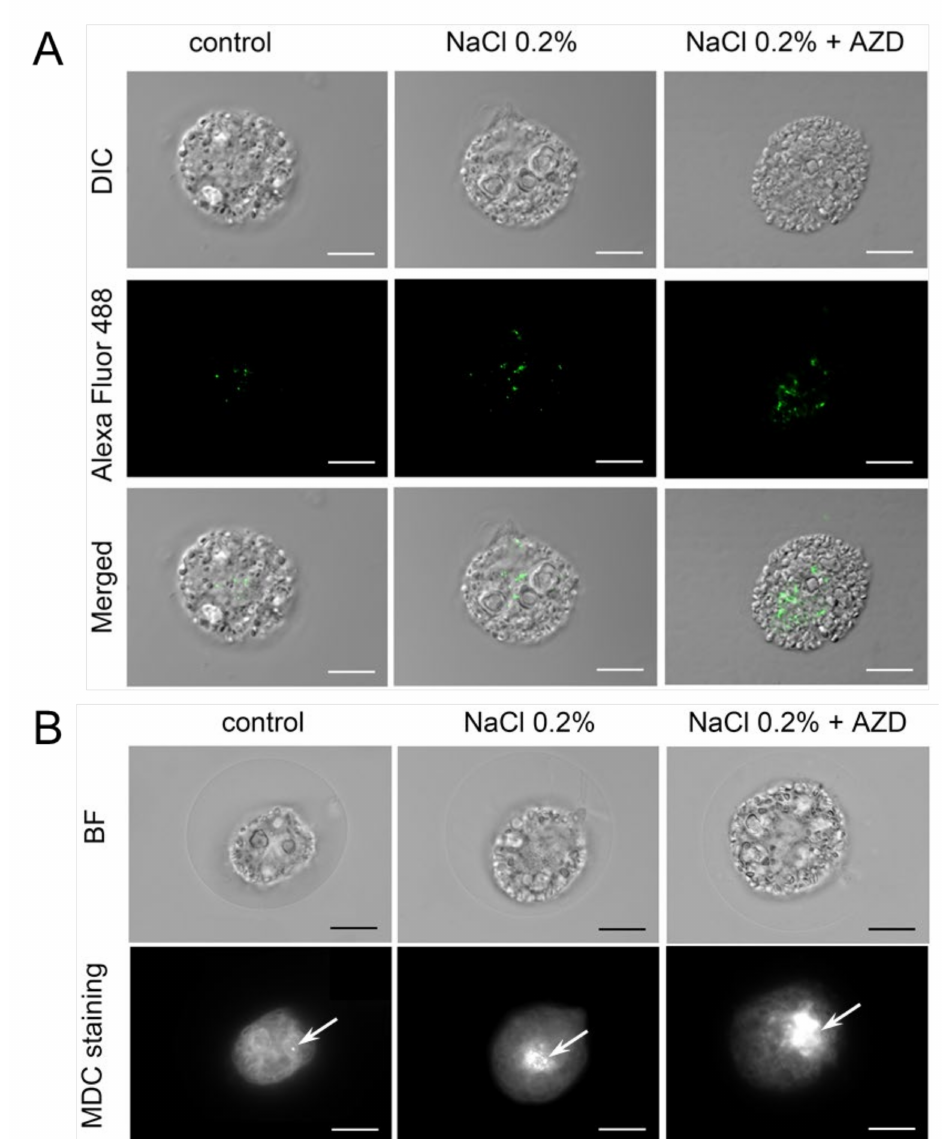
Figure 4. Visualization of autophagosomes in cells of Haematococcus lacustris cultured for three days either in OHM (control) or in OHM supplemented with 0.2% NaCl with or without addition of 0.2 µ M AZD8055 (AZD), respectively. ( A ) Immunofluorescence with anti-CrATG8 antibody. ( B ) Staining with monodancyl cadaverine (MDC) after incubation of the cells with 1 µ M concanamycin A for 24 h. DIC, Differential Interference Contrast; BF, bright field. White arrows point at a single autophagosome (control) or at an aggregation of autophagosomes. Bars denote 10 µ